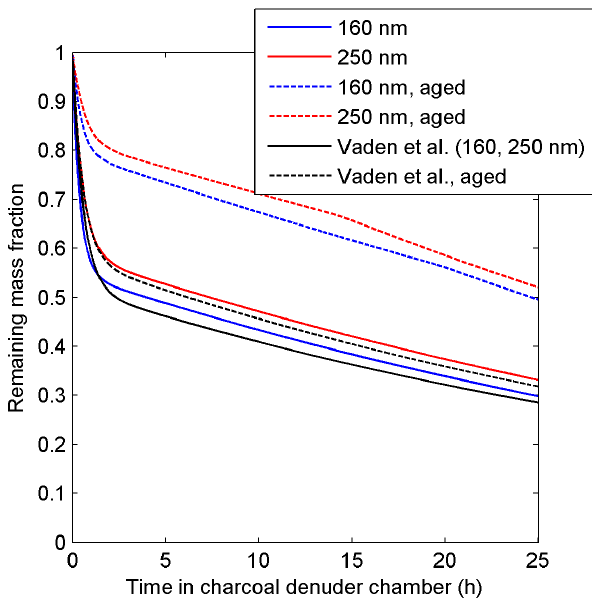
Figure 7. Measured (Vaden et al., 2011) and modelled evapora- tion loss rates for semi-solid tar-like particles ( D 0 , monomer = 5 × 10 − 17 cm 2 s − 1 and D oligomer = 0cm 2 s − 1 ). The fresh SOA parti- cles are composed of short-lived dimers ( ∼ 20mass%) and long- lived dimers (2.19 and 1.44mass% for 160 and 250nm particles, re- spectively) (see Fig. S9) before they are introduced into the charcoal evaporation chamber. The saturation vapour pressures were calcu- lated with SIMPOL and k ∗ g , w = 1 / 1000s − 1